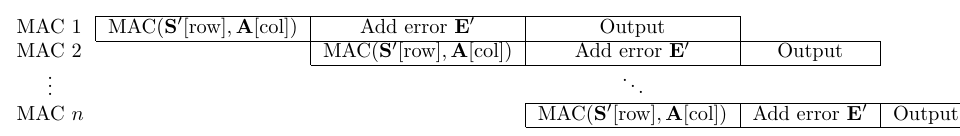
Figure 1: A high-level overview of the pipeline incorporated within the LWE multiplication core, for example B = S 0 A + E 0 . Latency is minimised due to parallelising the multiply- accumulate (MAC) operations within the DSP and additions with the error.